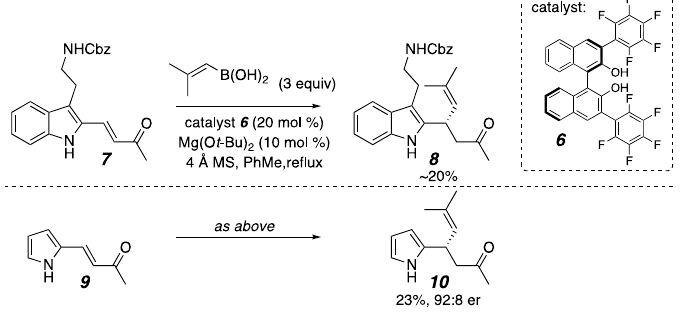
Figure 2. Problematic substrates for organocatalyzed conjugate